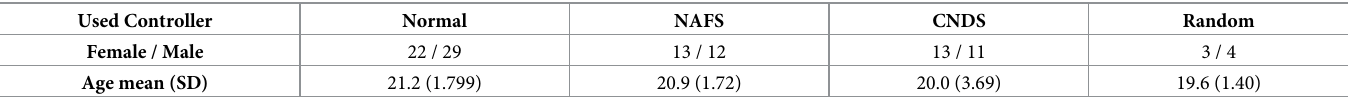
Table 1. Participants who used normal, name appears after the first success (NAFS), change to normal controller after the first success (CNFS), and random controllers. Used